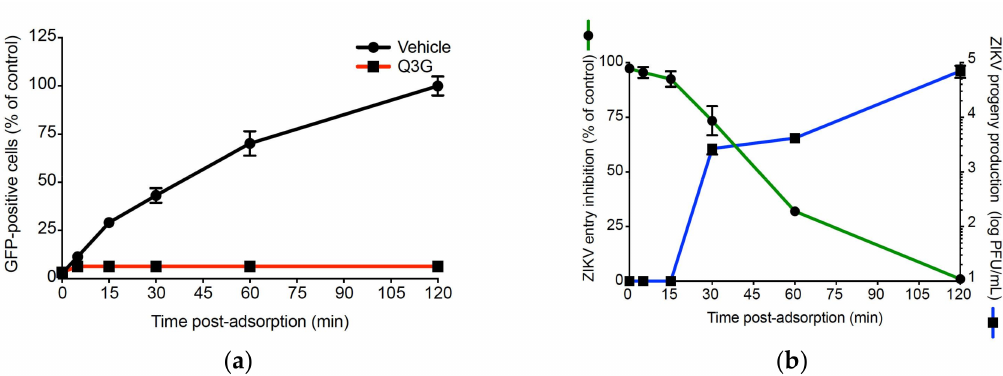
Figure 5. Q3G inhibits ZIKV entry in A549 cells. A549 cells were incubated 1 h with ZIKV GFP at 4 ◦ C and temperature was shifted to 37 ◦ C in absence (vehicle) or presence of 100 µ M Q3G. The percentage of GFP-positive cells was determined at 24 h p.i. In ( a ), attached and non-internalized virus particles were removed with citrate buffer at different time points post-adsorption. In ( b ), Q3G was added at different time points post temperature shift. The green curve represents the inhibition of ZIKV entry calculated from the percentage of GFP-positive cells. The blue curve represents the virus titers. Data represent the means ± SD of four independent experiments performed in triplicate.